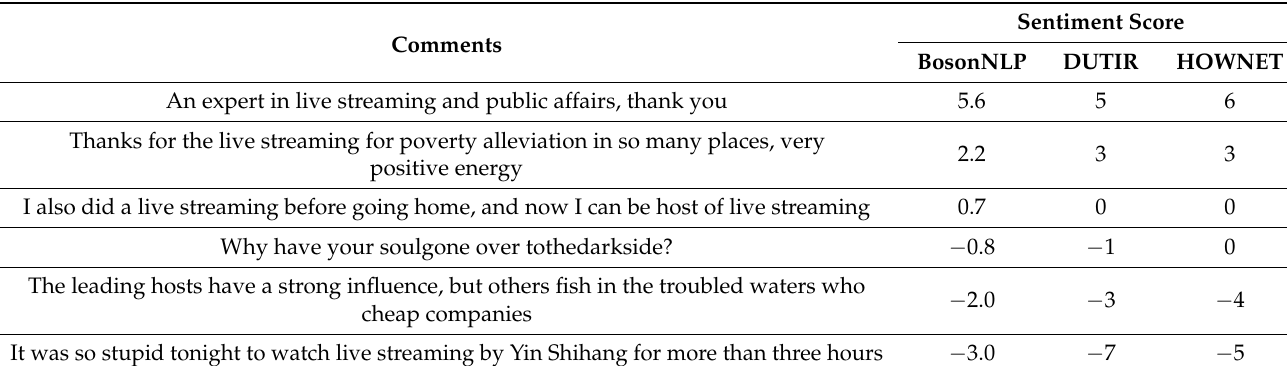
Table 11. Sentiment scores based on different methods.